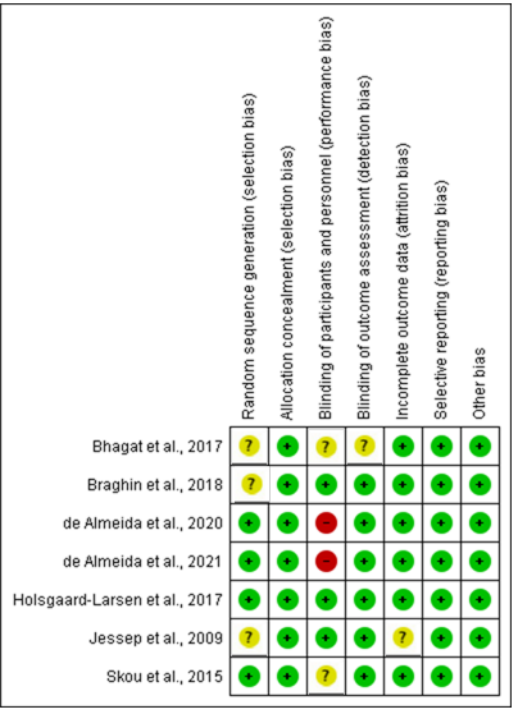
Figure 3. Risk of bias summary: review authors’ judgments about each risk of bias item for each included study [33,38–43]